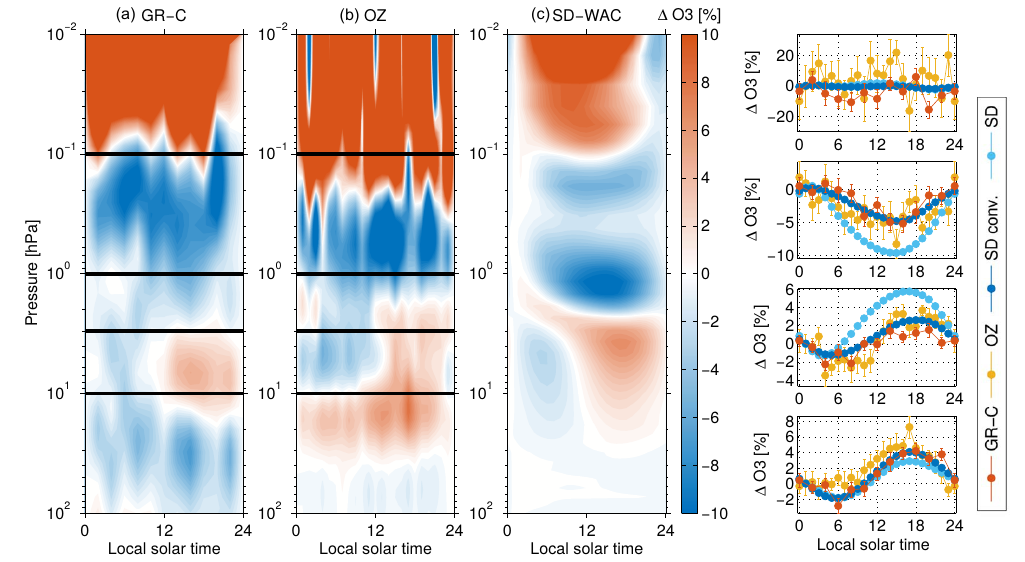
Figure 13. Same as in Fig. 9 but averaged over 42 days starting on 1 June